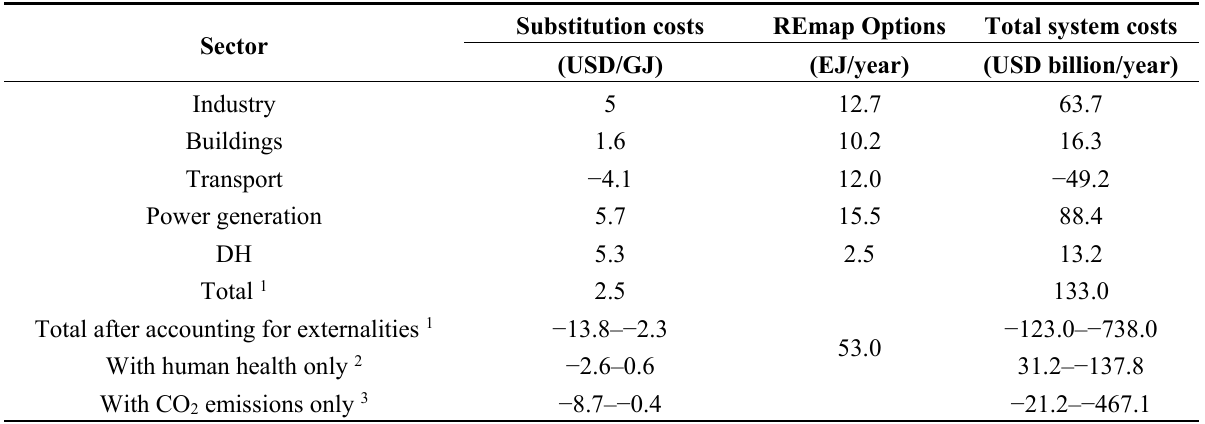
Table 4. Global average substitution costs of REmap Options in 2030 with a breakdown by